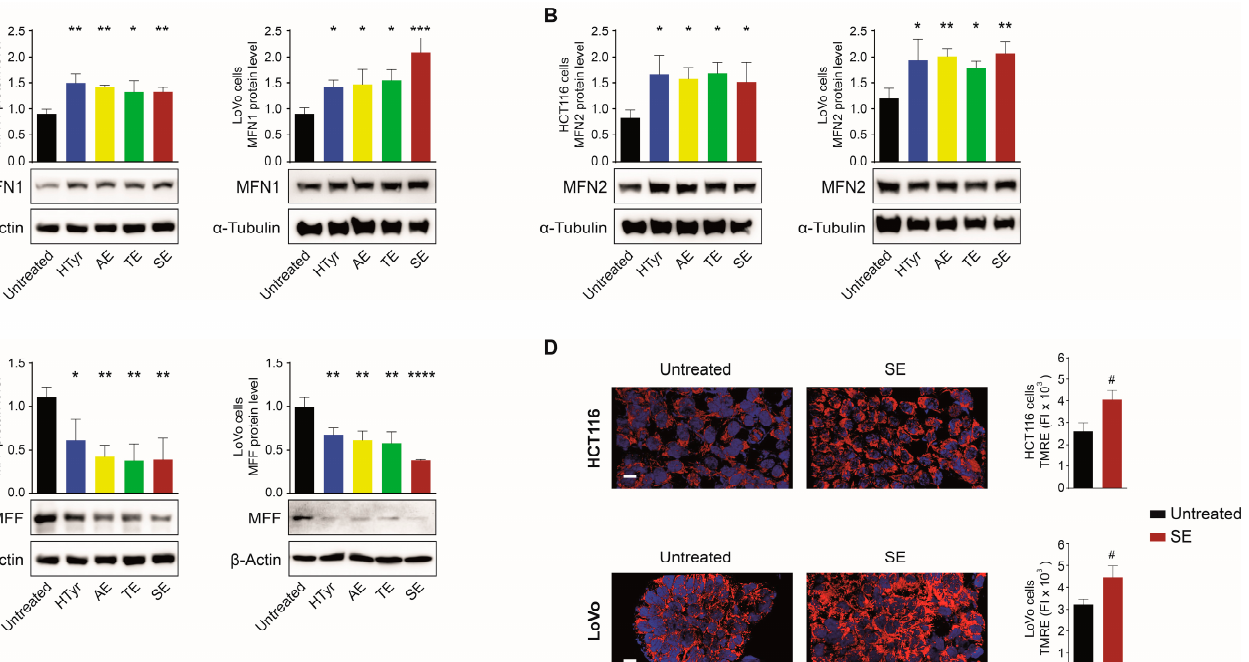
9 of 16 on the right illustrate the values of the mitochondrial mass calculated as Fluorescence Intensity (FI) with the ImageJ software, as described in Materials and Methods; immunoblot analysis of FOXJ3 ( C ), PGC-1 α ( D ), and TFAM ( E ) as mitochondrial biogenesis markers in HCT116 and LoVo cells treated as in ( A ). The histograms illustrate the results expressed as protein levels after normalization